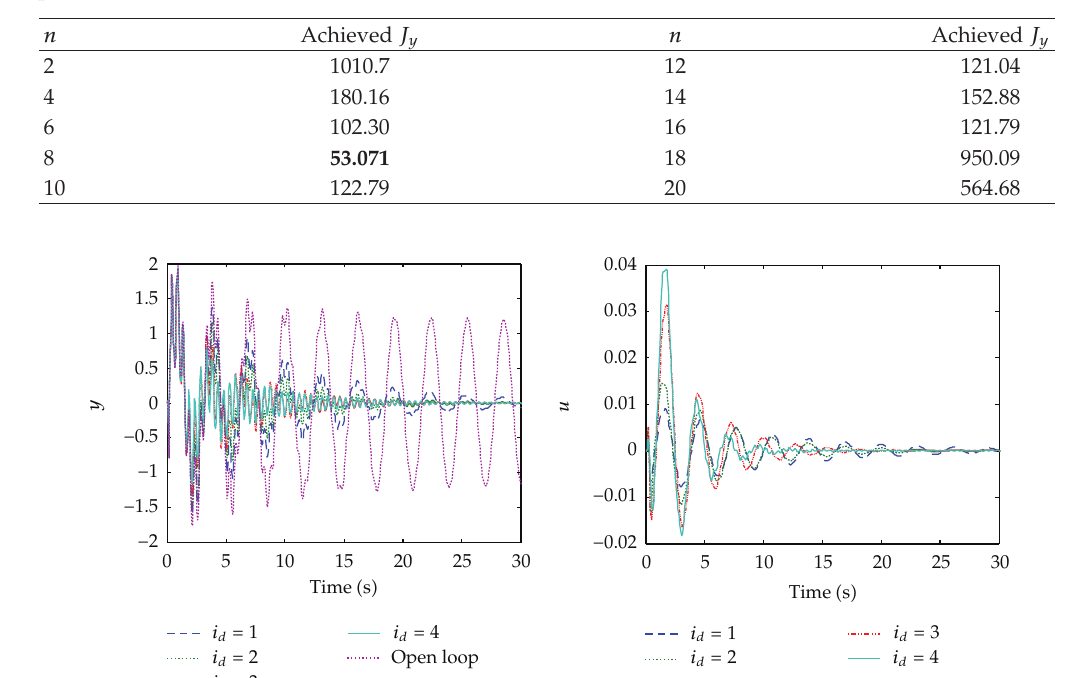
Table 1: The achieved value of the performance index J y for each order of the ARX model. The best control performance is achieved in n (cid:7) 8.